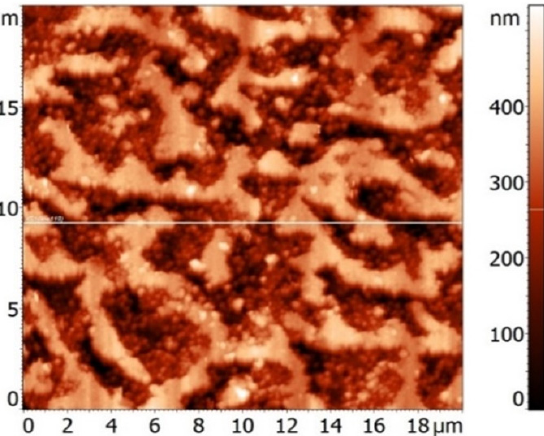
Figure 2. AFM image of the surface of pyrolyzate composed of nanoscale and submicron aggregates forming a porous matrix.